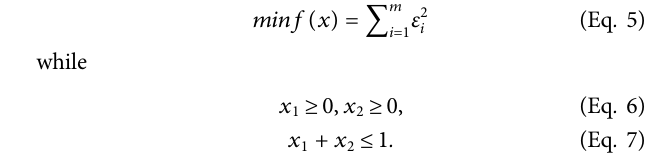
Frontiers in Earth Science |